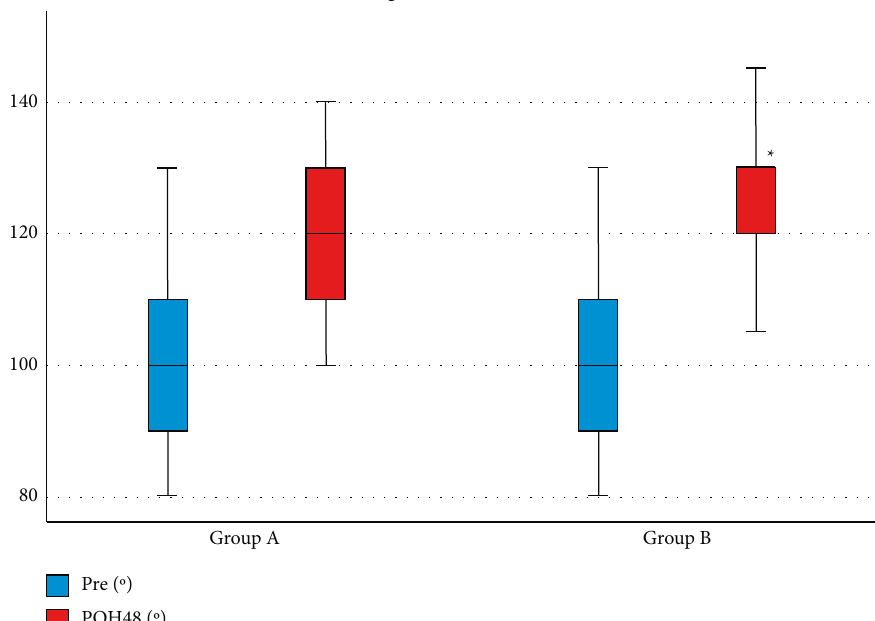
Figure 3: Mean range of knee flexion and extension before operation (Pre) and at postoperative hours (POH48), ∗ P < 0 .